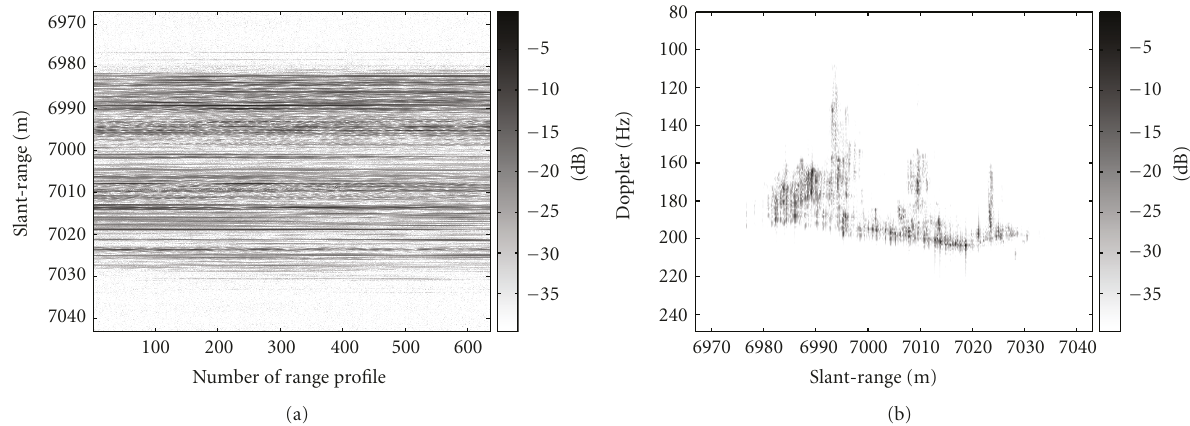
Figure 16: (a) Range profiles and (b) ISAR image for the real data of the vessel after using the global range alignment algorithm.